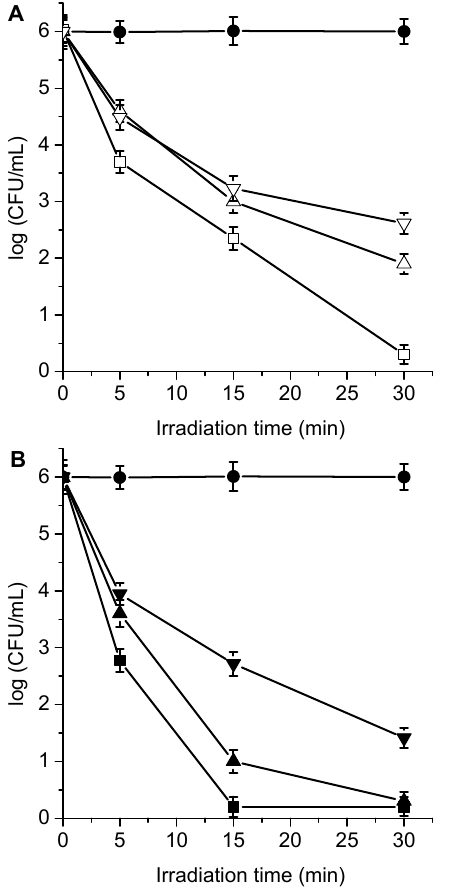
Figure 5. Survival of C. albicans (~10 6 UFC/mL) treated with ( A ) 1 μ M TPCF 16 (  ), 1 μ M ZnTPCF 16 (  ), 1 μ M PdTPCF 16 (  ), ( B ) 5 μ M TPCF 16 (  ), 5 μ M ZnTPCF 16 (  ), and 5 μ M PdTPCF 16 (  ) for 30 min at 37 °C in the dark and irradiated with white light for different irradiation times. Control of C. albicans untreated with PS and irradiated ( 